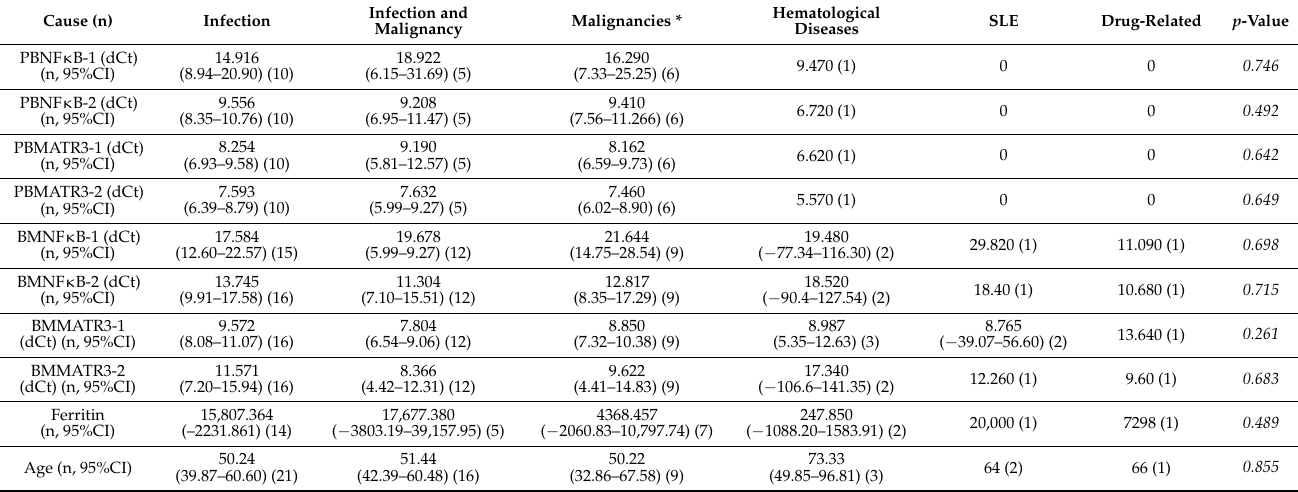
Table 3. Gene expression in different etiology of hemophagocytosis.